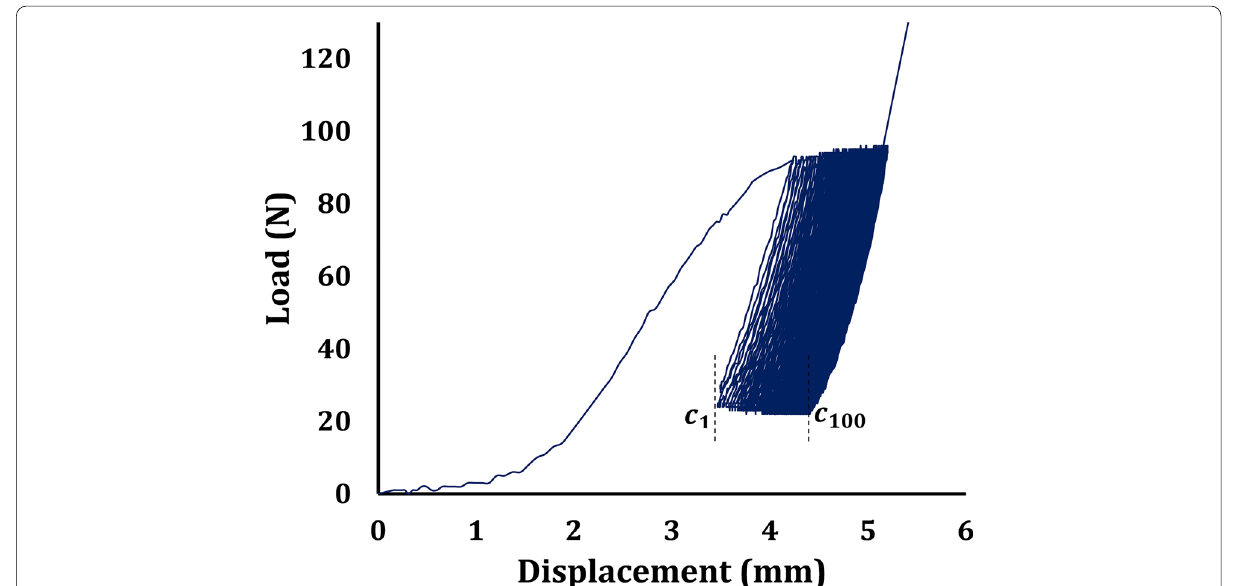
Fig. 9 Force-displacement curve of the cyclic sinusoidal loading of a typical specimen. The graft slippage was determined as the displacement between c1-c100